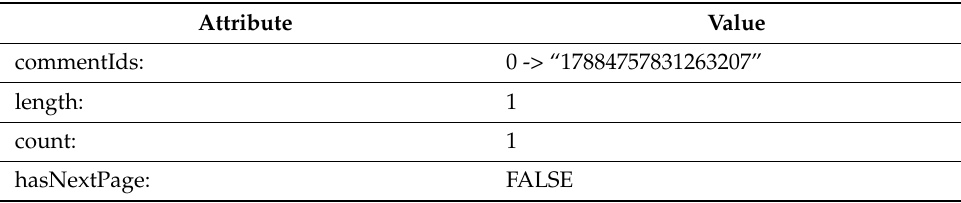
Table 8. Artifacts Found in comments.byPostId